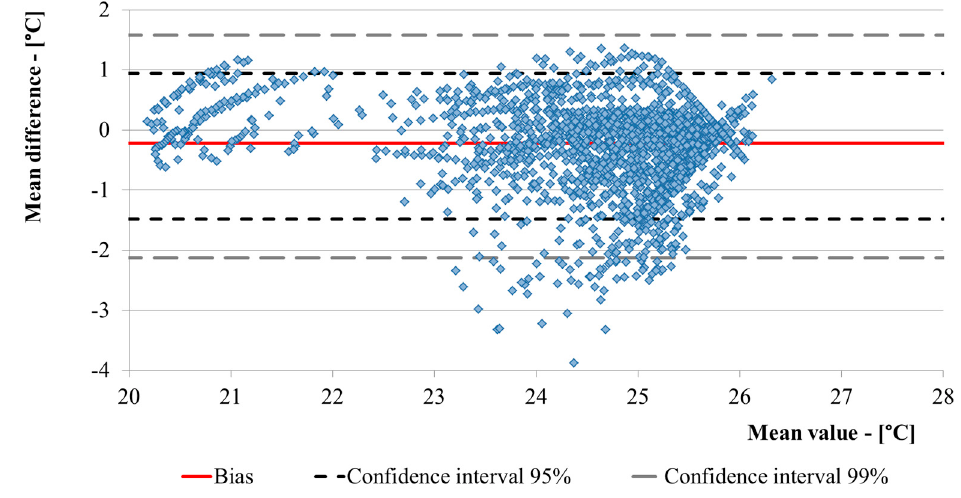
Figure 10. Bland-Altman plot: internal Figure 10. Bland ‐ Altman plot: internal temperature.